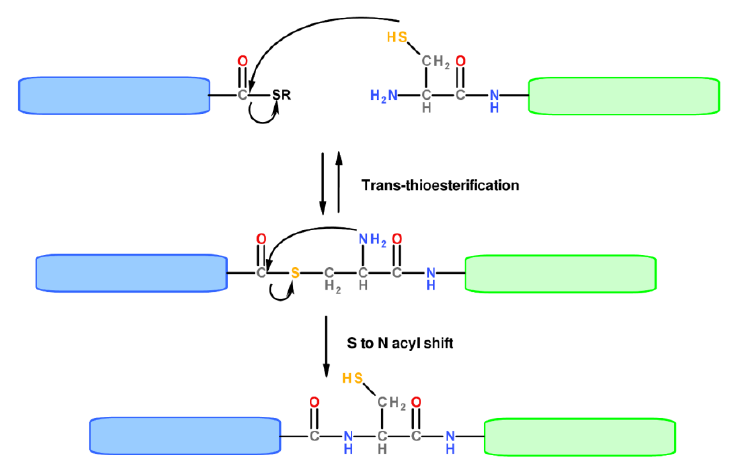
Figure 3. Mechanism of the NCL